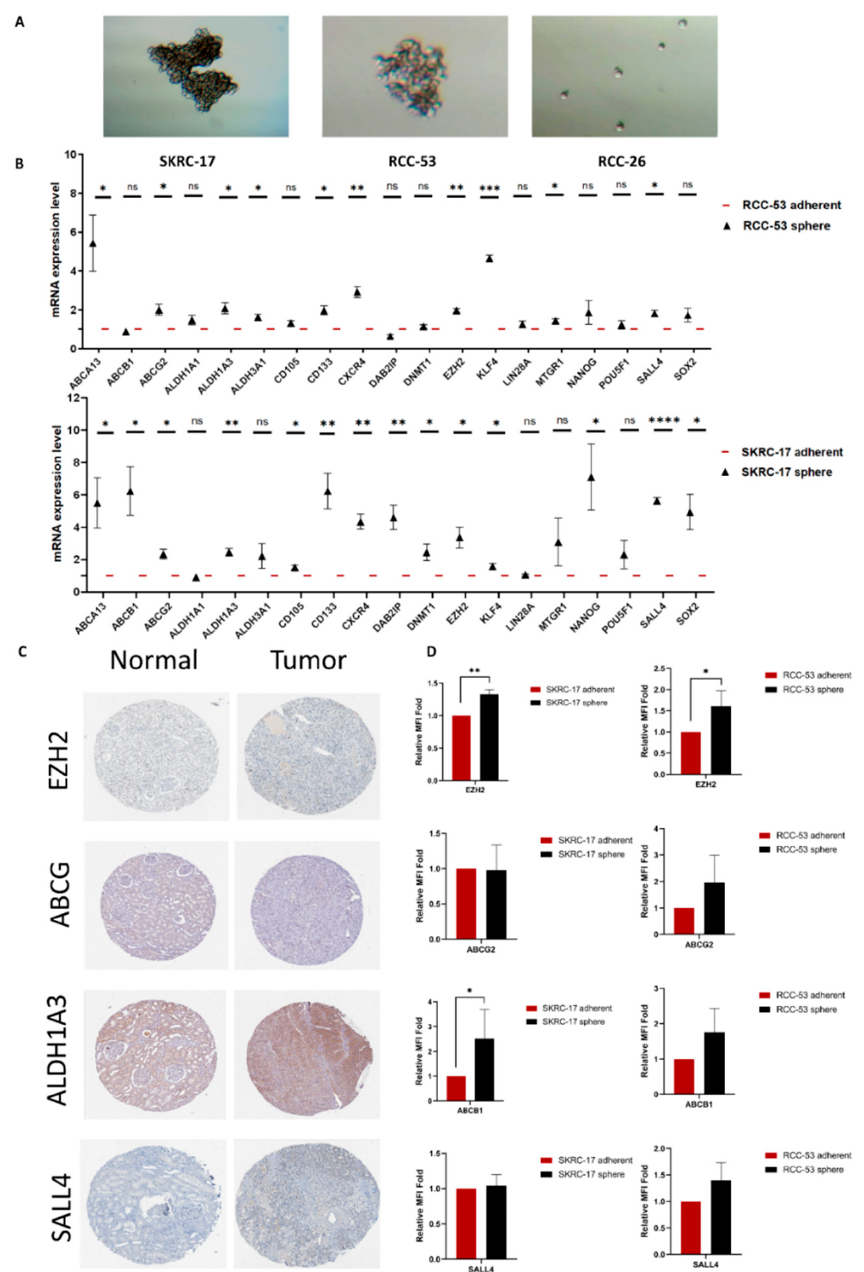
Figure 3. The sphere formation ability of the RCC cell lines and the expression of potential CSC markers on the mRNA and protein levels. ( A ) Sphere formation: SKRC-17 and RCC-53 formed spheres around day 7, RCC-26 did not. Photos were taken by a microscope digital camera at the magnification of 100 × (Bresser GmbH DE-46414 Rhede Germany). ( B ) mRNA expression of 19 potential CSC markers in SKRC-17, RCC-53, and their corresponding CSCs analyzed by RT-qPCR analysis ( p < 0.05 indicates statistical significance), the expression level observed in spheres was normalized to the corresponding adherent line. * p < 0.05, ** p < 0.01, *** p < 0.001, **** p < 0.0001. ( C ) Representative images of IHC staining for the EZH2, ABCG2, ALDH1A3, and SALL4 expression in the KIRC and normal tissue, photos derived from the Human Protein Atlas database. ( D ) Measurement of the protein expression in the adherent and sphere cell lines by flow cytometry ( n = 3, adherent cell value was set as